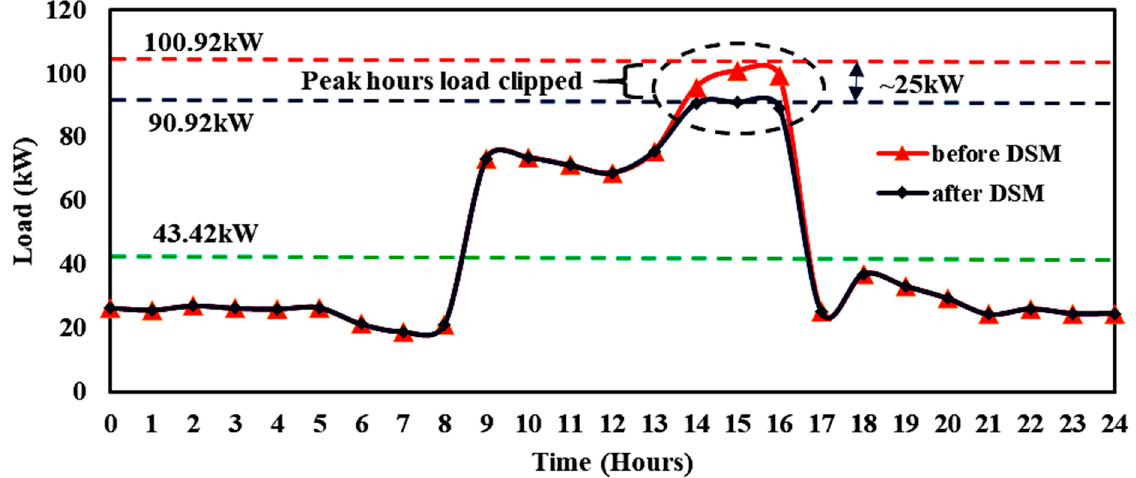
Figure 4. Peak clipping in daily load profile. Table 6. Peak clipped 25 kW load shifted from afternoon to morning.